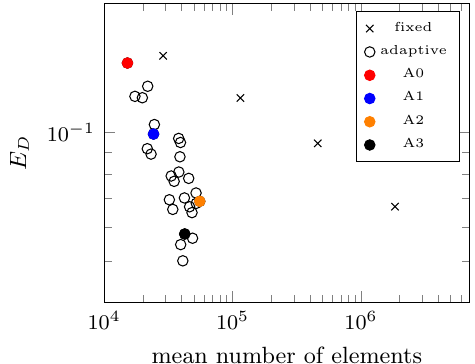
Figure 3. Time-integrated energy conservation error, E D , against the mean number of elements for a range of two-dimensional simu- lations using fixed and adaptive meshes. Adaptive simulations rep- resent a parameter sweep of interpolation error bounds with val- ues 4 × 10 − 3 , 4 × 10 − 2 . 5 and 4 × 10 − 2 for velocity and concentra- tion. Fixed meshes are on uniform triangular grids with edge lengths 5 × 10 − 2 , 2 . 5 × 10 − 2 , 1 . 25 × 10 − 2 and 6 . 25 × 10 − 3 . Four adaptive simulations are highlighted. The settings for these simulations are detailed in Table